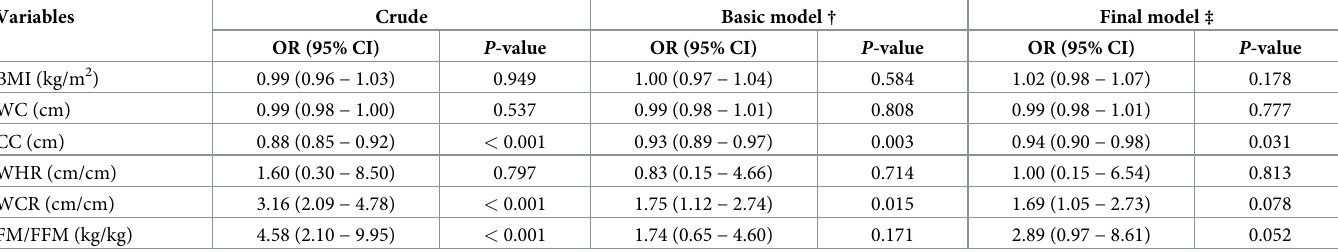
Table 2. Logistic regression analyses of the association of BMI, WC, CC, WHR, WCR and FM/FFM with cognitive impairment. Variables